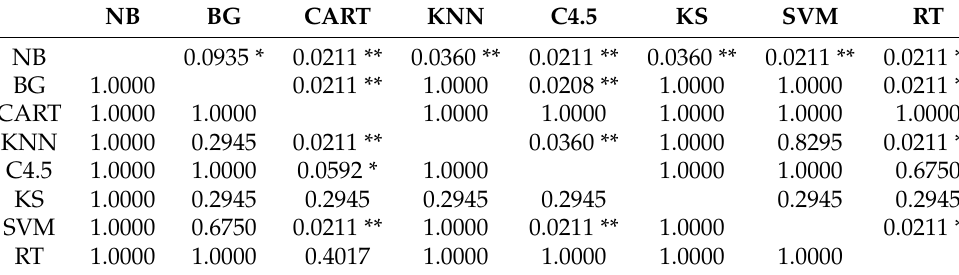
Table 20. Pairwise WSR test for AUROC of adolescents.